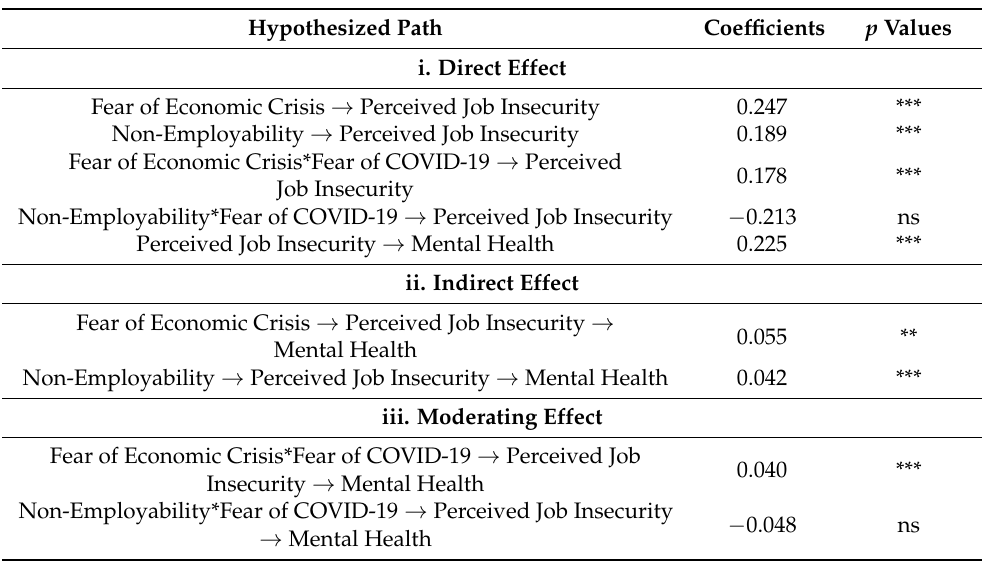
Table 4. Results for structural equation model.